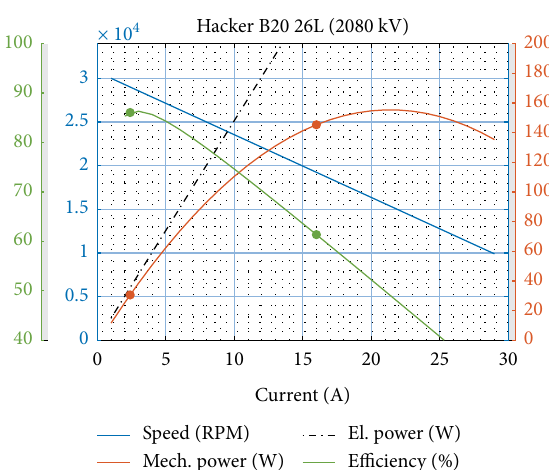
Figure 11: Simulated operating characteristics of Hacker B20 26L brushless motor.